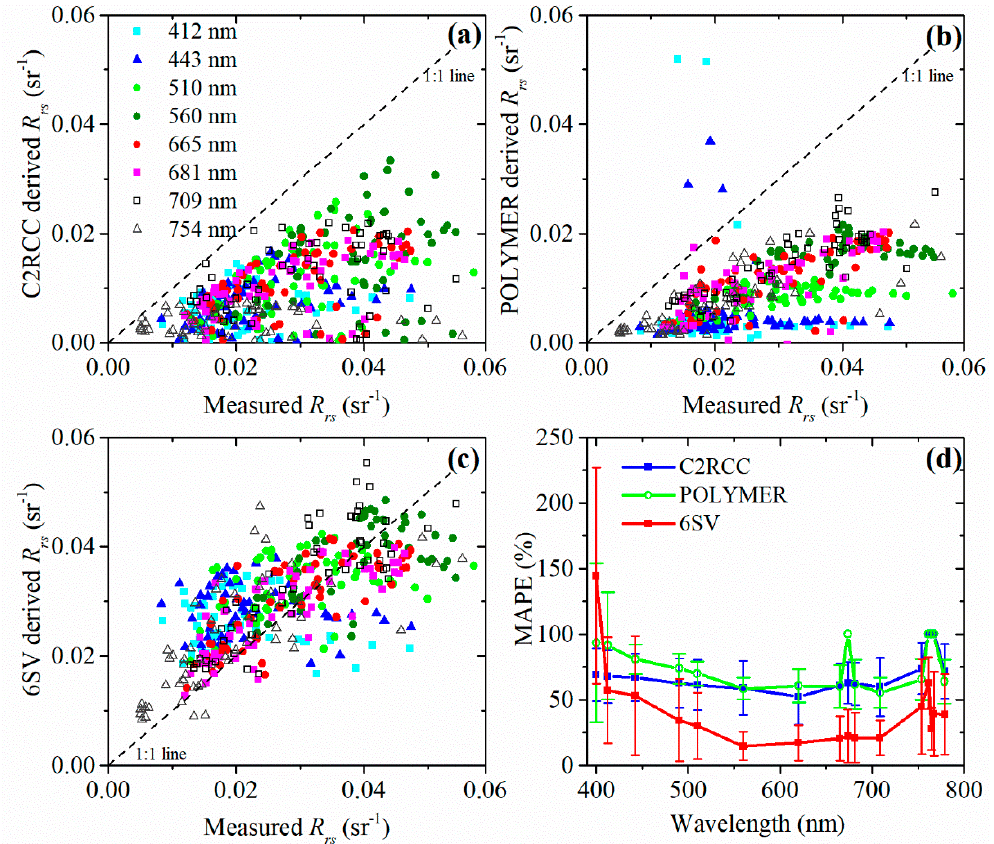
Figure 2. Comparison of the field-measured R rs and OLCI-derived R rs using the ( a ) C2RCC, ( b ) POLYMER, and ( c ) 6SV atmospheric correction models for match-up pairs at different OLCI bands ( N = 63). ( d ) MAPE of C2RCC, POLYMER, and 6SV at different OLCI bands, error bars represent one standard deviation of the absolute percentage error in the validation data.